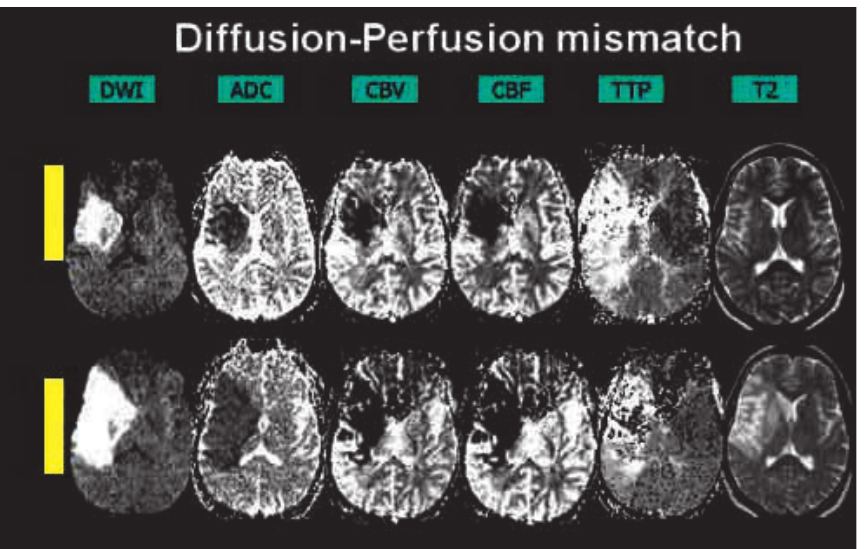
49-year old male with left-sided weakness. The diffusion image shows an area of hyperintensity in the MCA territory on the right side, sur- rounded by a larger area of hypoperfu- sion. The next MRI shows lesion growth into the surrounding